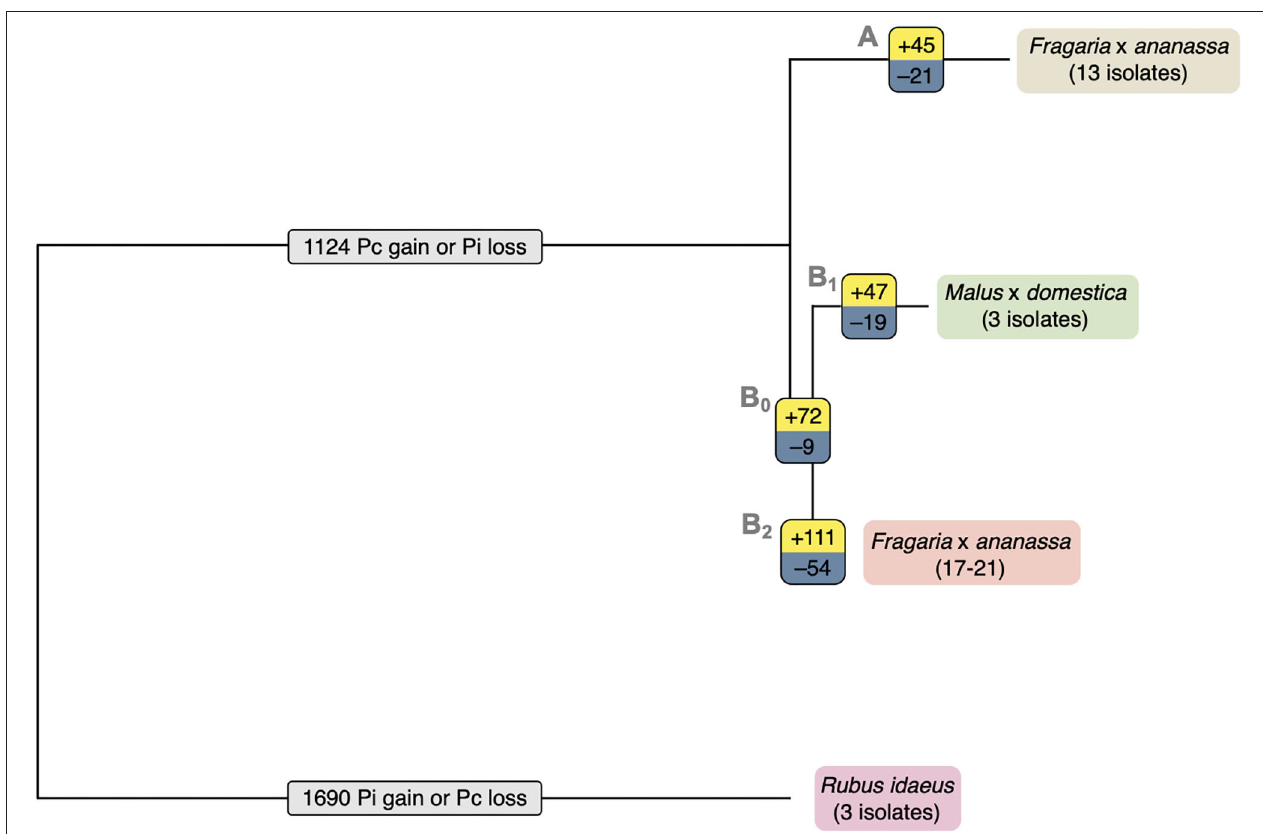
FIGURE 4 | Expansion and contraction of orthogroups indicates possible roles in P. cactorum host specialisation. Expansion and contraction of orthogroups plotted onto simple phylogeny. The number of expanded orthogroups of each branch are shown in yellow, the number of contracted orthogroups of each branch are shown in blue and the numbers of orthogroups with unsure direction of expansion or contraction are shown in light grey. The strawberry crown rot lineage (branch A) includes isolates P414, P404, P415, P416, P421, 4032, 4040, 12–420, 2003–3, 10300, 15–7, 15–13, and PC13/15. The apple lineage (branch B 1 ) includes isolates R36/14, P295, and